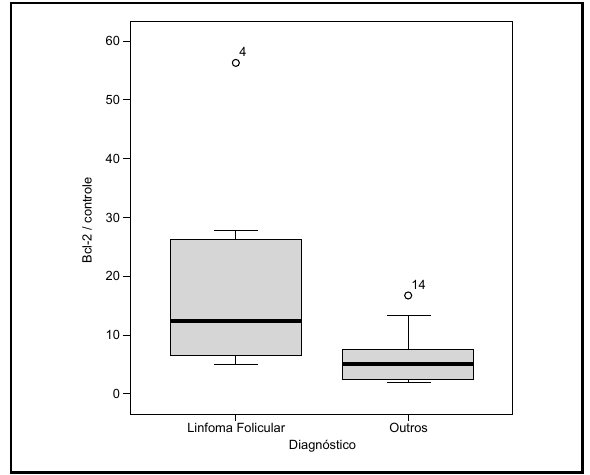
Figura 3 – Diferença de expressão da proteína Bcl-2 em linfócitos B de linfoma folicular e de outras doenças linfoproliferativas crônicas B. Os valores estão relatados em inten- sidade média relativa de fluorescência. As caixas representam os valores de percentis 25 e 75; a linha do meio e as linhas verticais correspondem ao valor de mediana e aos percentis 10 e 90 respectivamente ( p = 0,032; teste de